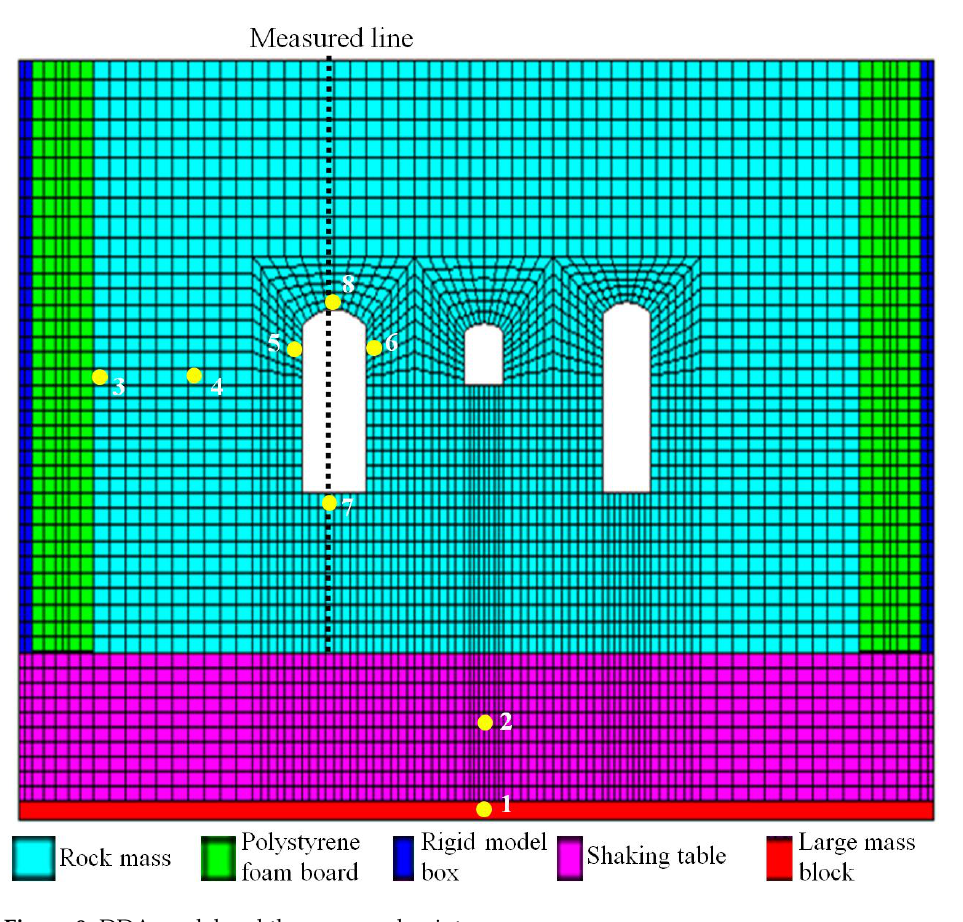
Figure 9. DDA model and the measured points. Table 3. Physical and mechanical parameters of various